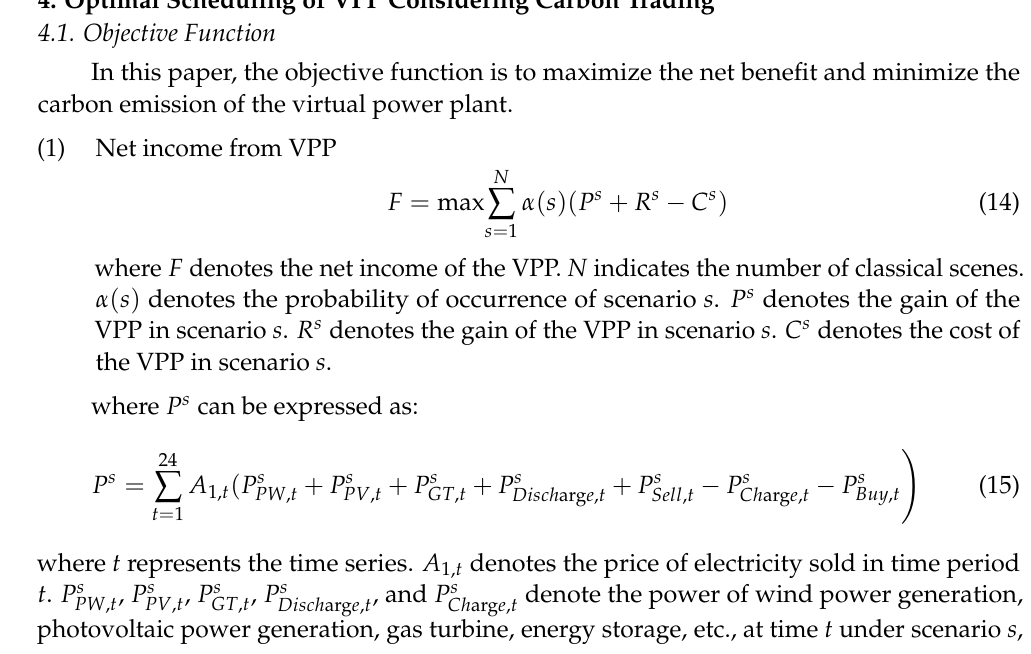
Figure 1. Flow chart of improved CLARA algorithm based on the Latin hypercube sampling algo- rithm.